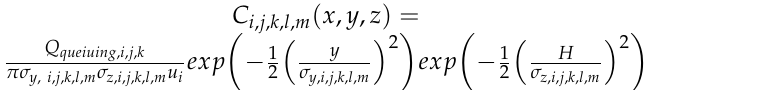
Figure 14. Weibull descriptors and lower and upper confidence level of air pollution concentra ‐ tion, x = 250 m ( left ) and x = 500 m ( right ), (cid:1840)(cid:1841) (cid:1876) . Figure 15. Weibull descriptors and lower and upper confidence level of air pollution concentra ‐ tion, x = 750 m ( left ) and x = 1000 m ( right ), (cid:1840)(cid:1841) (cid:1876) .